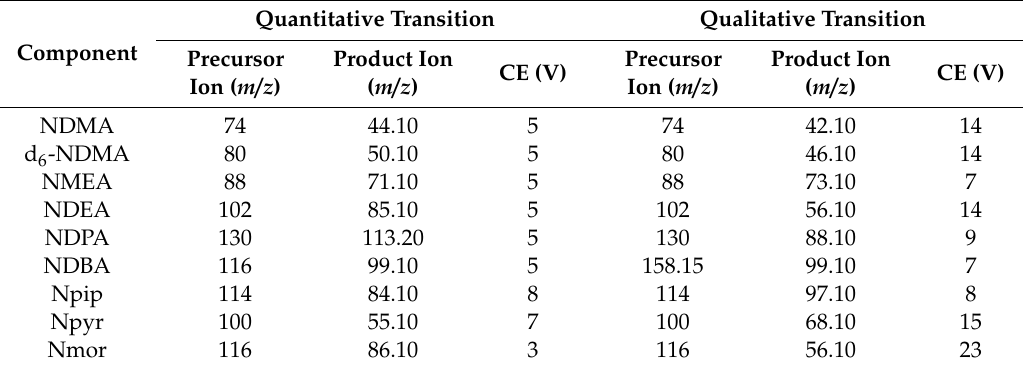
Table 3. MRM transitions for analyzed